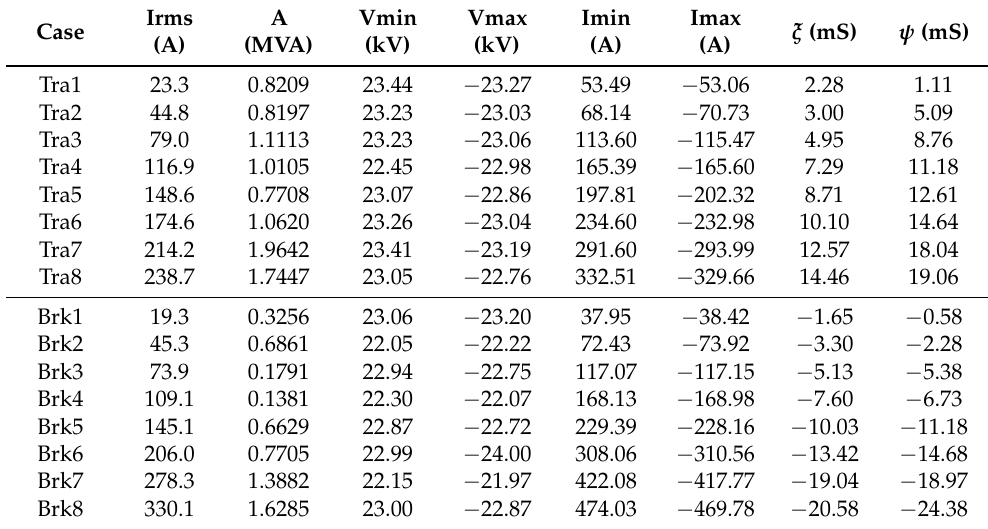
Table 2. VI diagram parameters for Germany (case numbering from 1 to 8, following Figure 5).